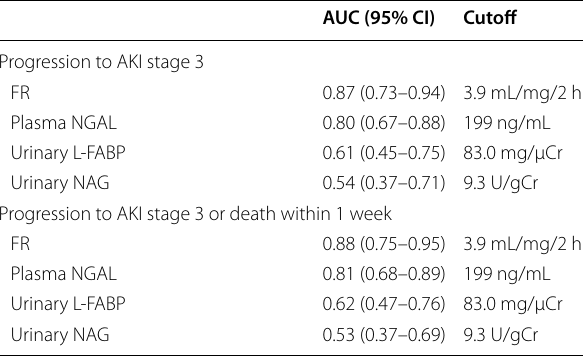
Table 2 ROC analysis for the progression to AKI stage 3 or death within 1 week